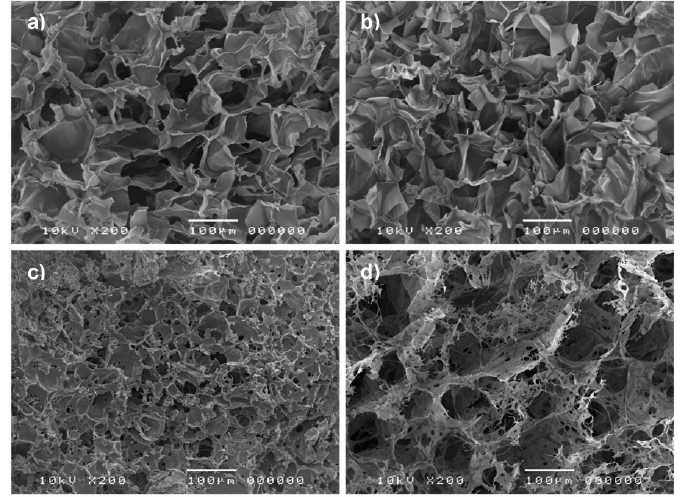
Figure 2. SEM images of pure CS ( a ), CS / PL ( b ), CS / PL / BGP hydrogels ( c ), and CS / PL / BGP / GE hydrogels ( d ). Polymers 2020 , 12 , x